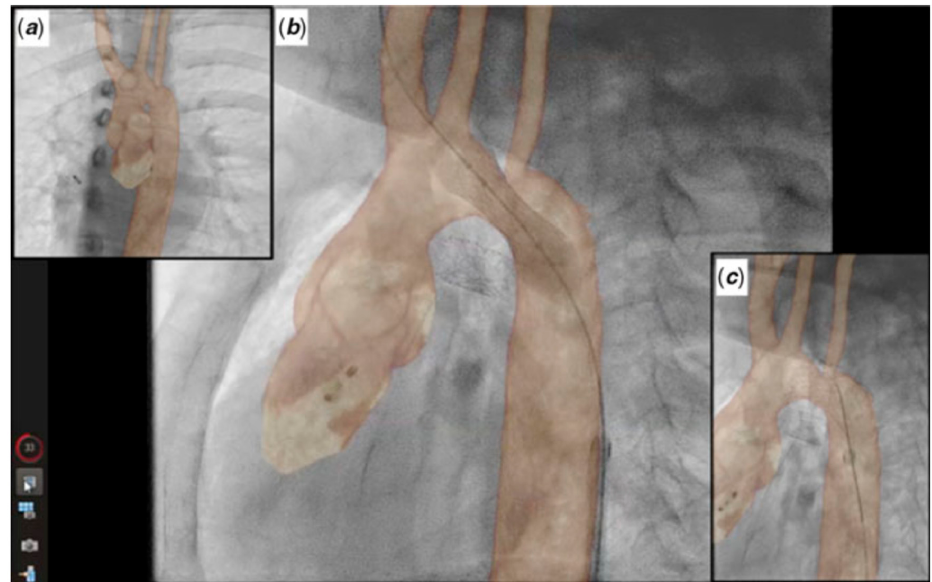
Figure 16. Series of overlay fluoroscopy images depicting CoA stenting at different camera angula- tions ( a , b ) as well as side cell dilation to avoid jailing the LSCA ( c ). Revised from ref [9] .